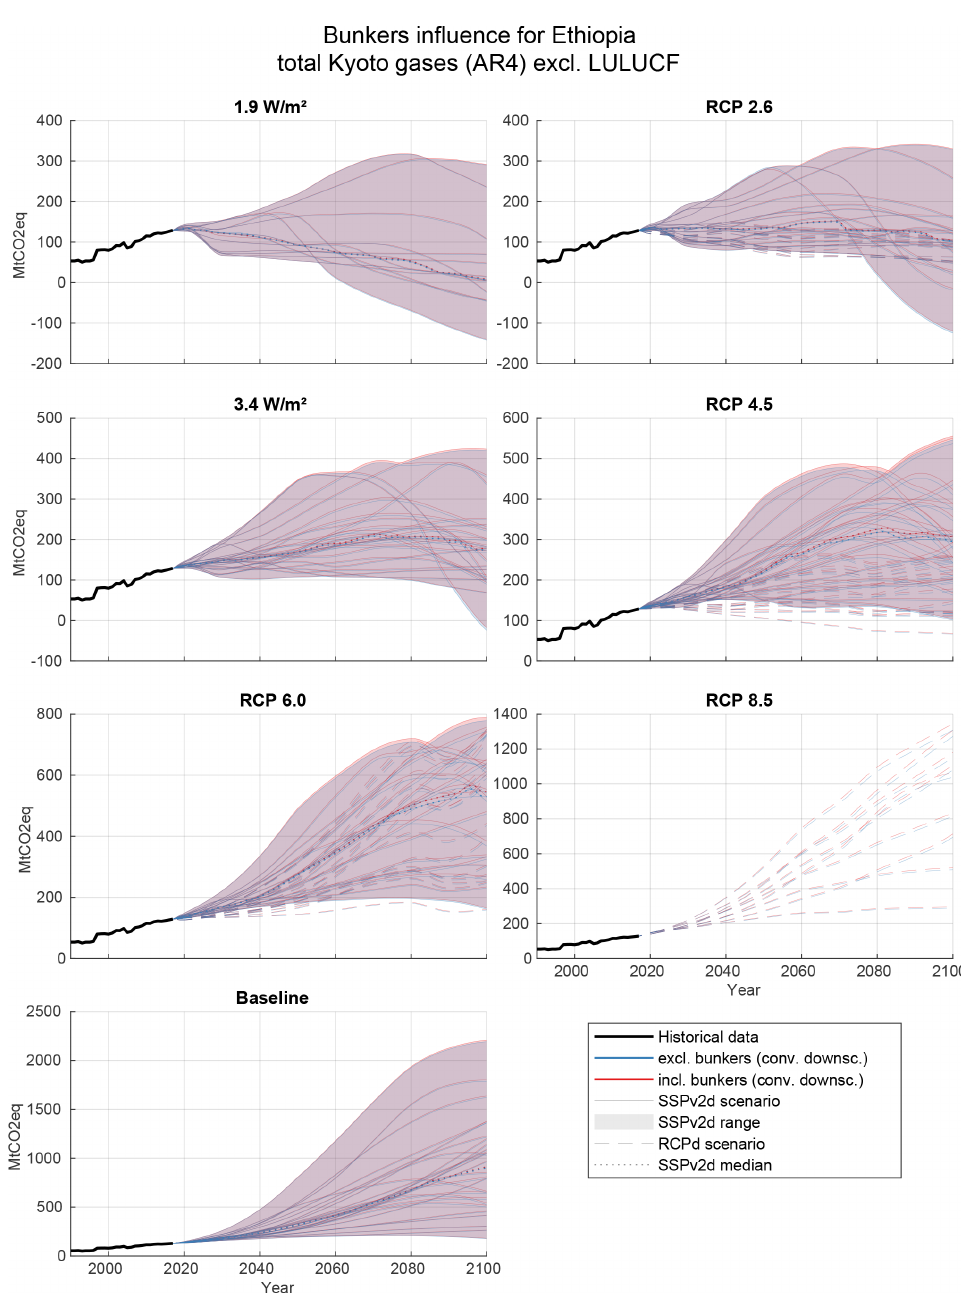
Figure 13. Influence of bunker emissions on results for Ethiopia. Ranges and the median are calculated over all SSPs and all IAM implemen- tations in SSPv2d for each RCP. RCPd scenarios are shown as individual lines only (dashed). Generally the influence of bunker emissions is much smaller than for the EU, because the global bunker scenario is split into regions using historical shares which are high for the OECD and REF regions (EU) and low for the Africa region compared with future